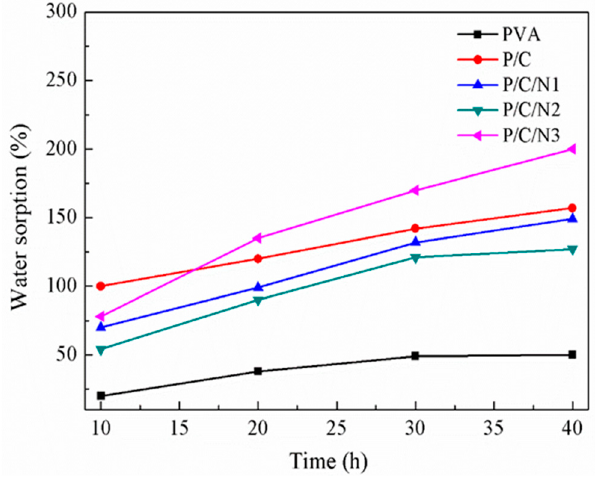
Figure 6. Water sorption of PVA, P/C, P/C/N1, P/C/N2, and P/C/N3 composite films.